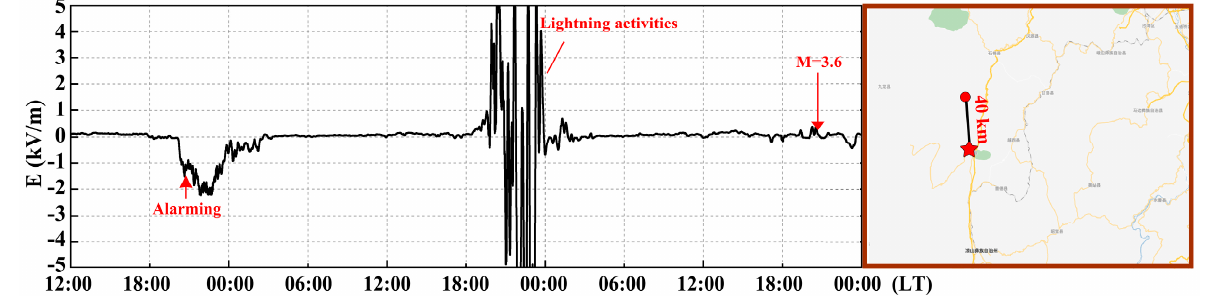
Figure 2. Negative atmospheric electrostatic field Ez signal before the Mianning M3.6 earthquake. The circle indicates the epicenter and the star indicates the Mianning Station.